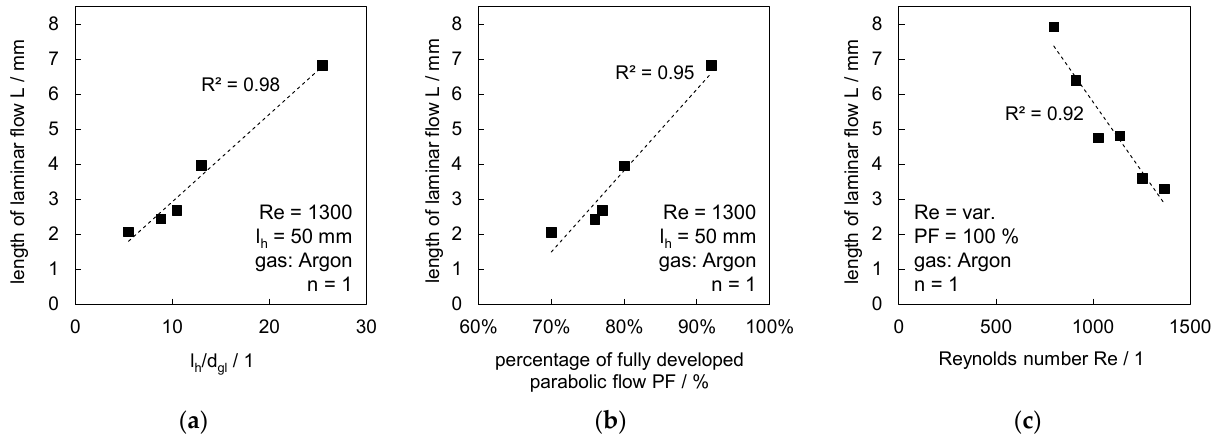
Figure 8. Length of laminar flow depending on: ( a ) l h /d gl ; ( b ) percentage of fully developed parabolic flow; ( c ) Re .